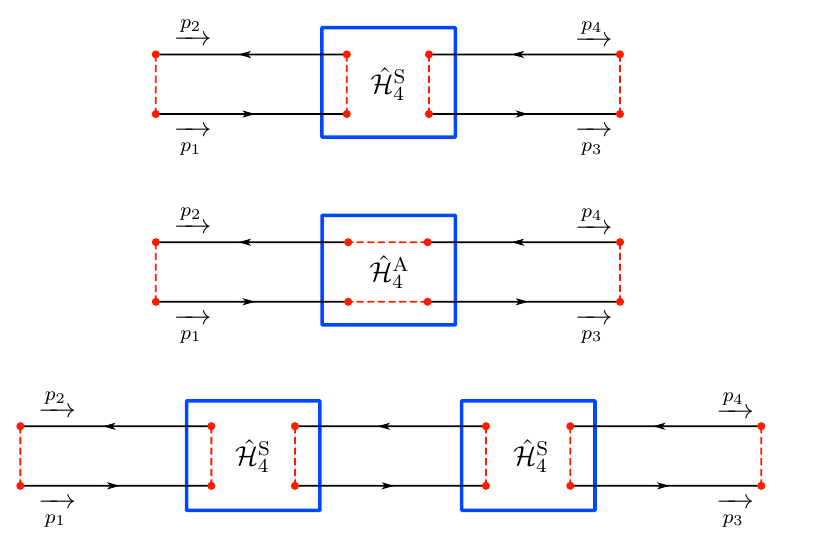
Figure 2 . Tree-level leading and subleading contributions and one-loop leading contribution to scattering in the Lippmann-Schwinger